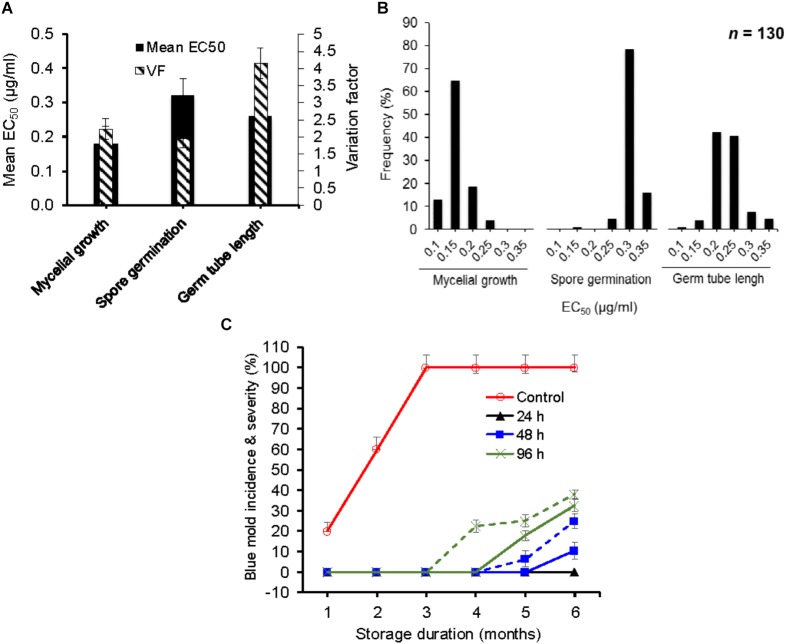
In vitro and in vivo efficacy of difenoconazole against baseline isolates of Penicillium expansum.
(A) Mean effective concentration of difenoconazole for 50% growth, germination and germ tube elongation inhibition (EC50) and variation factor (VF, highest EC50/lowest EC50) of 130 baseline isolates of P. expansum.
(B) Frequency distribution of respective EC50 values among 130 baseline isolates of P. expansum.
(C) Temporal change in blue mold incidence (continuous lines) and severity (dashed lines) on detached apple fruit treated preventively with 0.26 mg/L of difenoconazole and inoculated with WT-isolates of P. expansum 24, 48, and 96 h post-treatment at 1°C and regular atmosphere. Data are the mean incidences from 3 WT-isolates (data were merged after no significance difference was observed between the isolates) and 58 fruit across two experimental runs. Data from the 12-h post-treatment inoculation are not shown because no disease was seen.